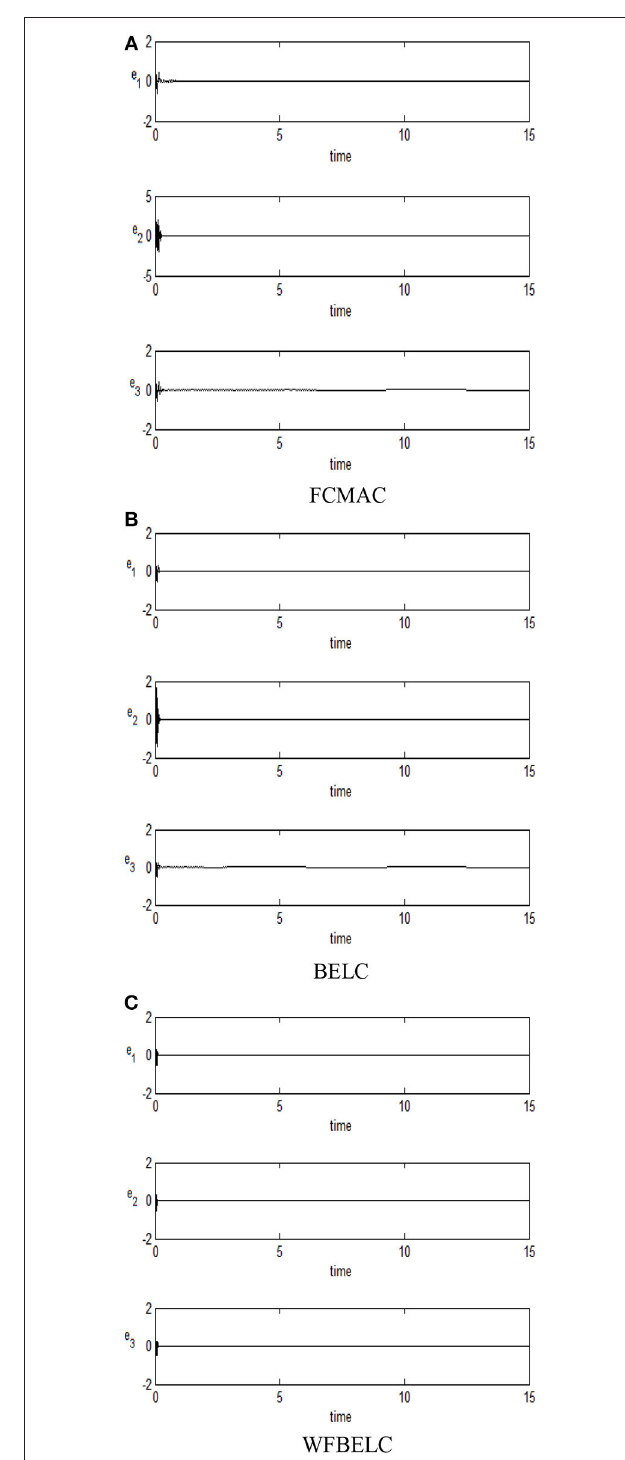
FIGURE 17 | Corresponding control inputs (A) FCMAC, (B) BELC, and (C) WFBELC. FIGURE 18 | Values of tracking error (A) FCMAC, (B) BELC, and (C)